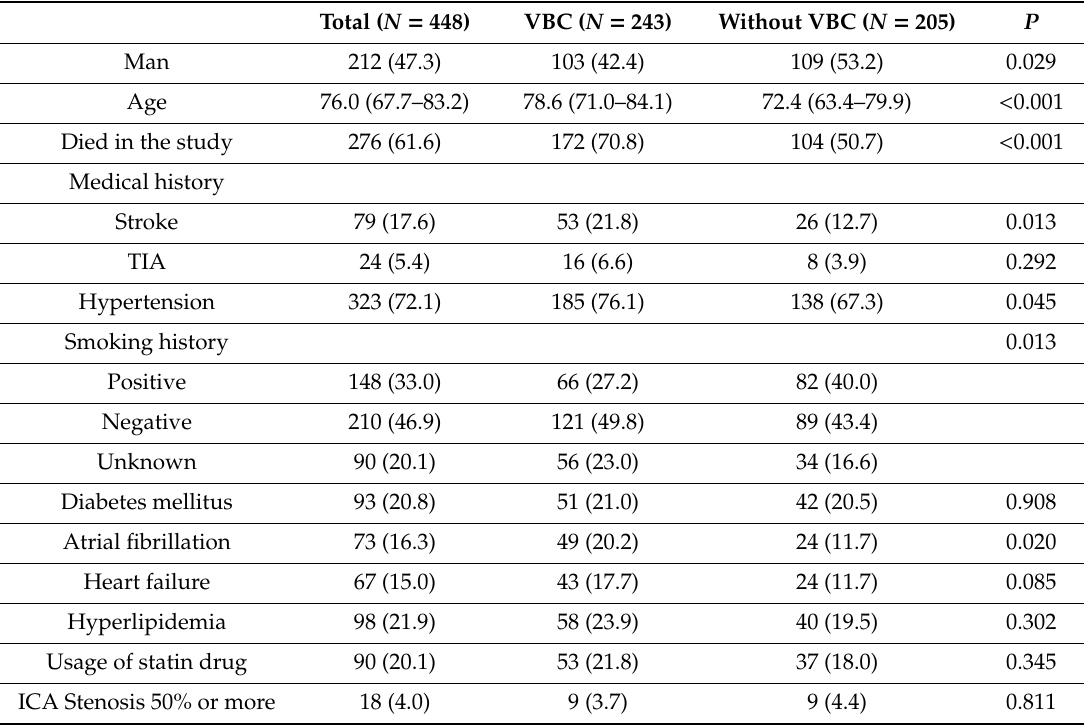
Table 1. Demographics, medical history, laboratory data, and stroke etiology of the 448 patients hospitalized due to ischemic stroke in the period from 9 / 2011 to 10 /